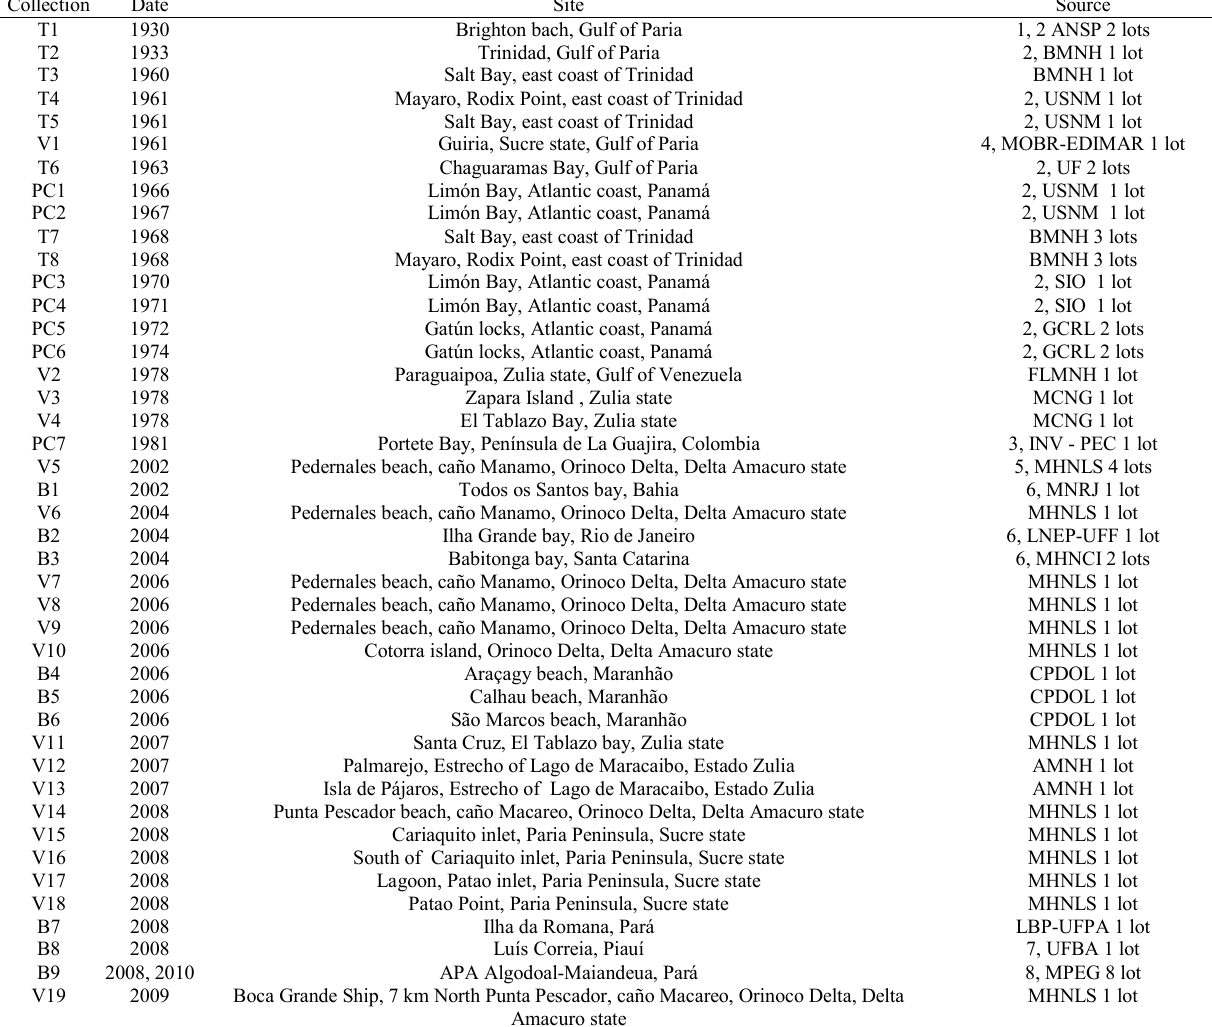
Table 1 . Records of Ombranchus punctatus from Trinidad (T), Panama and Colombia (PC), Venezuela (V) and Brazil (B). References from: 1 - Fowler (1931), 2 - Springer & Gomon (1975), 3 - Garzón-Ferreira (1989), 4 - Cervigón (1966), 5 - Lasso et al. (2004), 6 - Gerhardinger et al. (2006), 7 - Loebmann et al . (2010), and 8 - Soares et al . (2011).